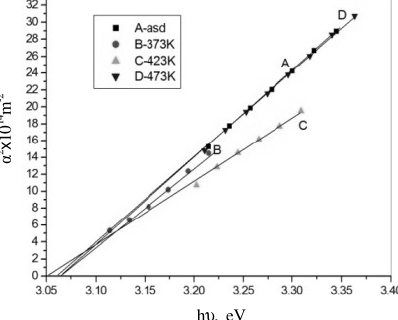
Figure 2. Plot of α 2 versus photon energy h ν for F (fundamental